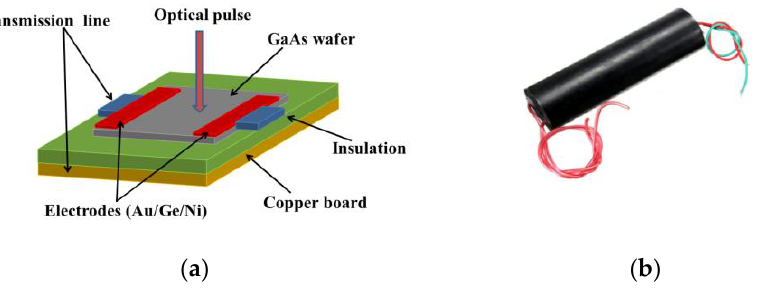
Figure 1. ( a ) Schematic diagram of the 3 mm gap lateral GaAs PCSS. ( b ) The power boost